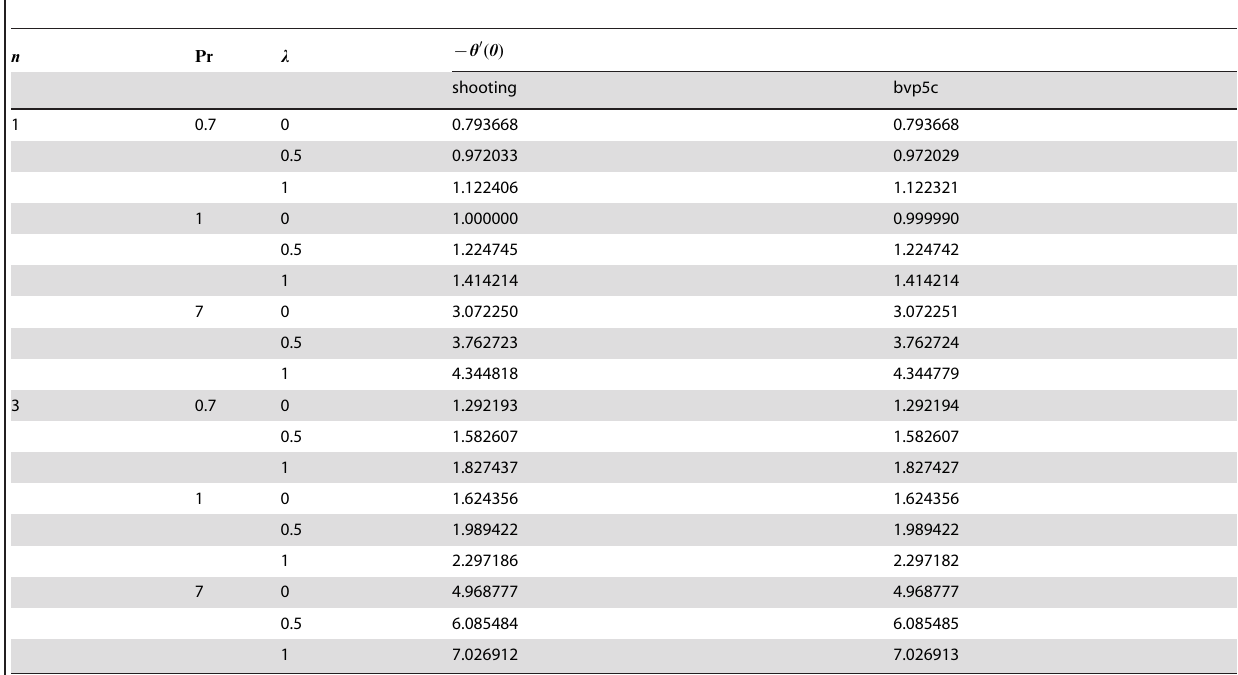
Table 3. Numerical values of local Nusselt number { h 0 (0) for various values of n , Pr and l